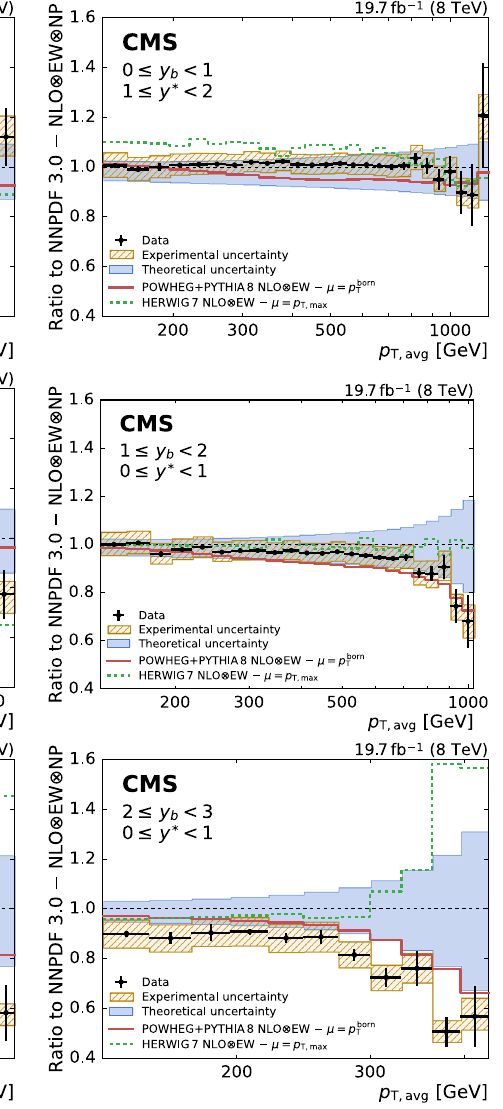
shows the PDF, scale, and NP uncertainties quadratically added. The predictions of the NLO MC event generators powheg + pythia8 and herwig7 are depicted by solid and dashed lines,